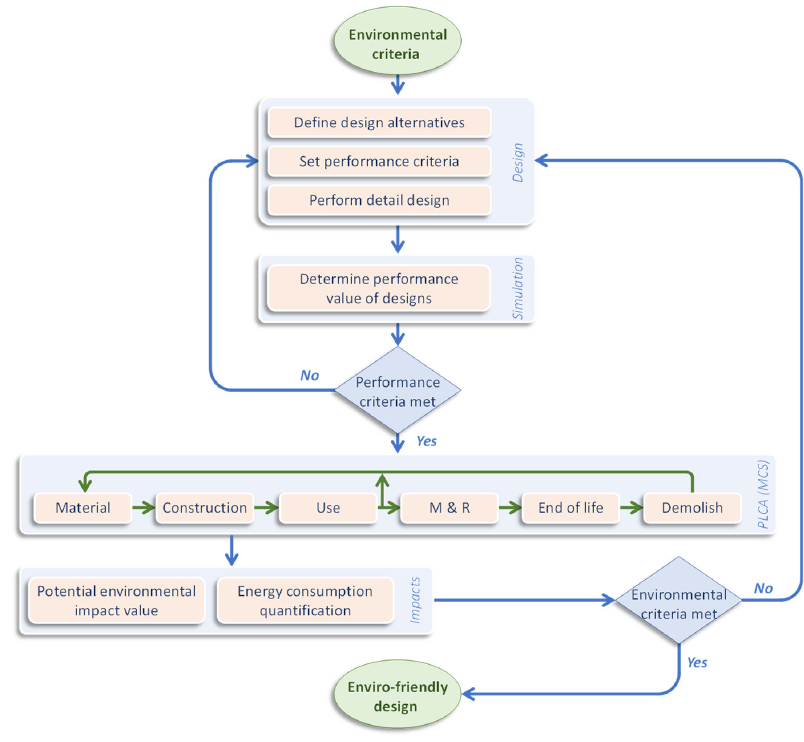
Figure 3. Probabilistic life cycle assessment framework.